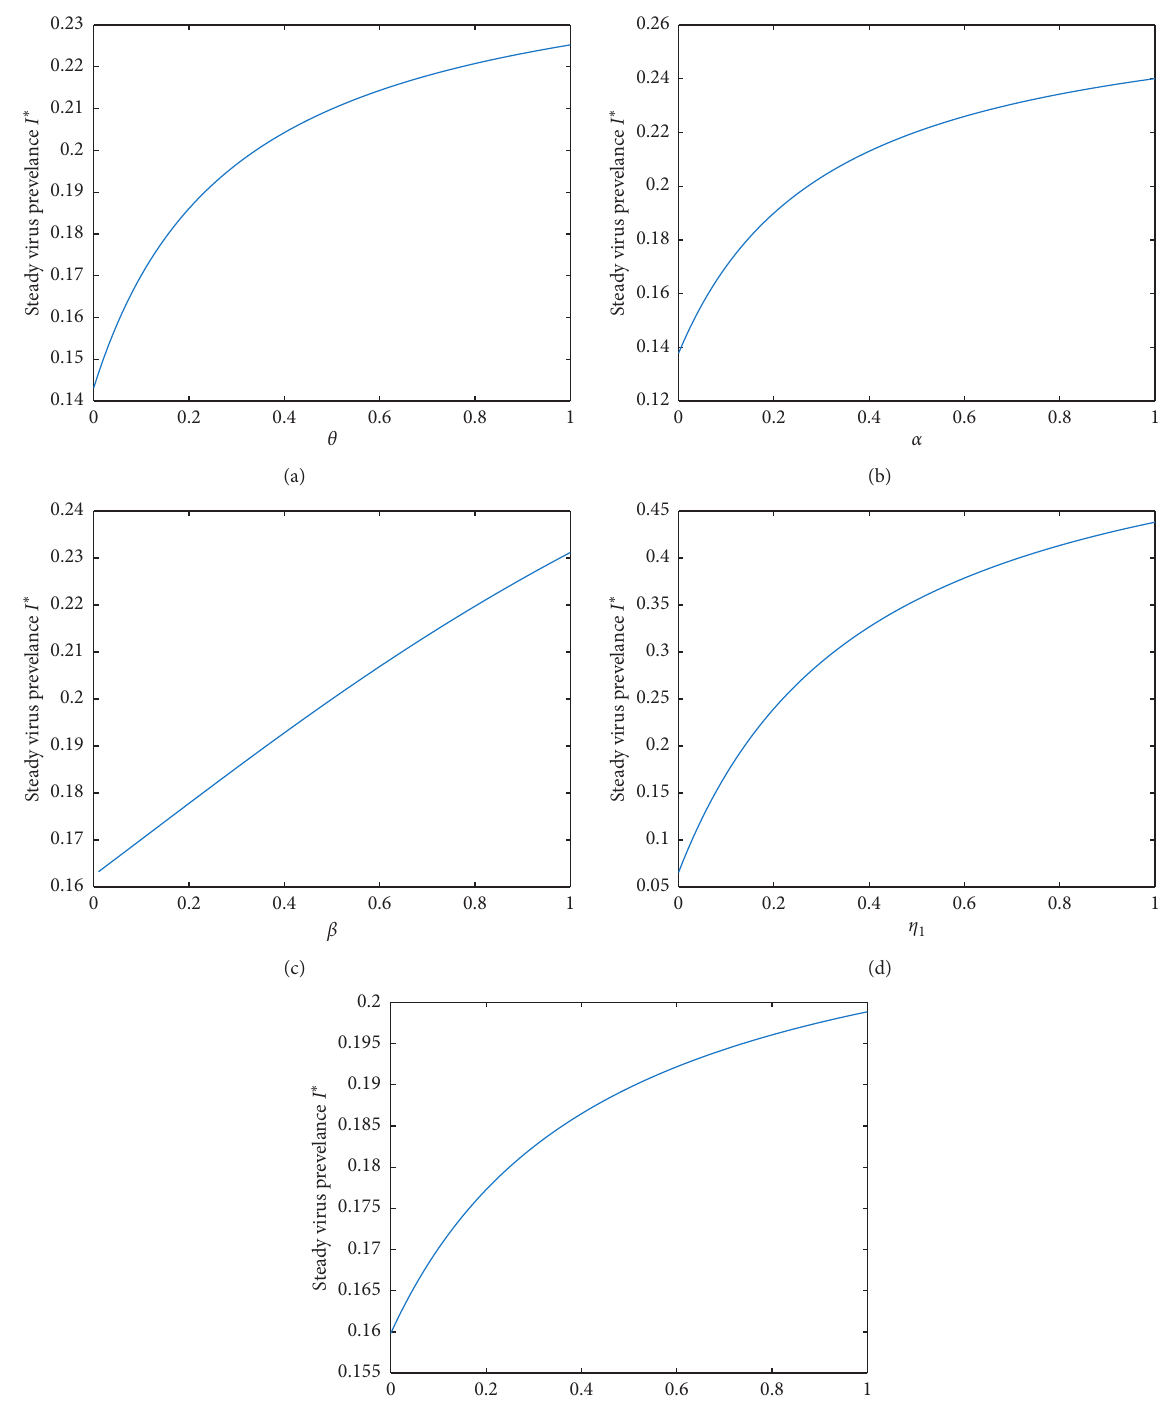
Figure 4: Evolution of I ∗ with the parameters: (a) θ , (b) α , (c) β , (d) η